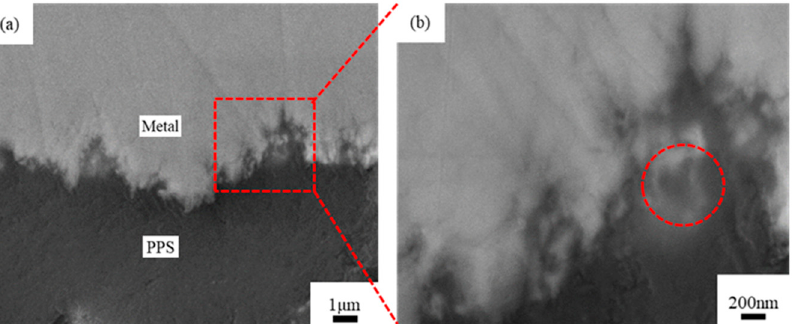
Figure 11. SEM images of metal-PPS bonding interface sections. ( a ) 5000× magnification; ( b ) 20,000× magnification.